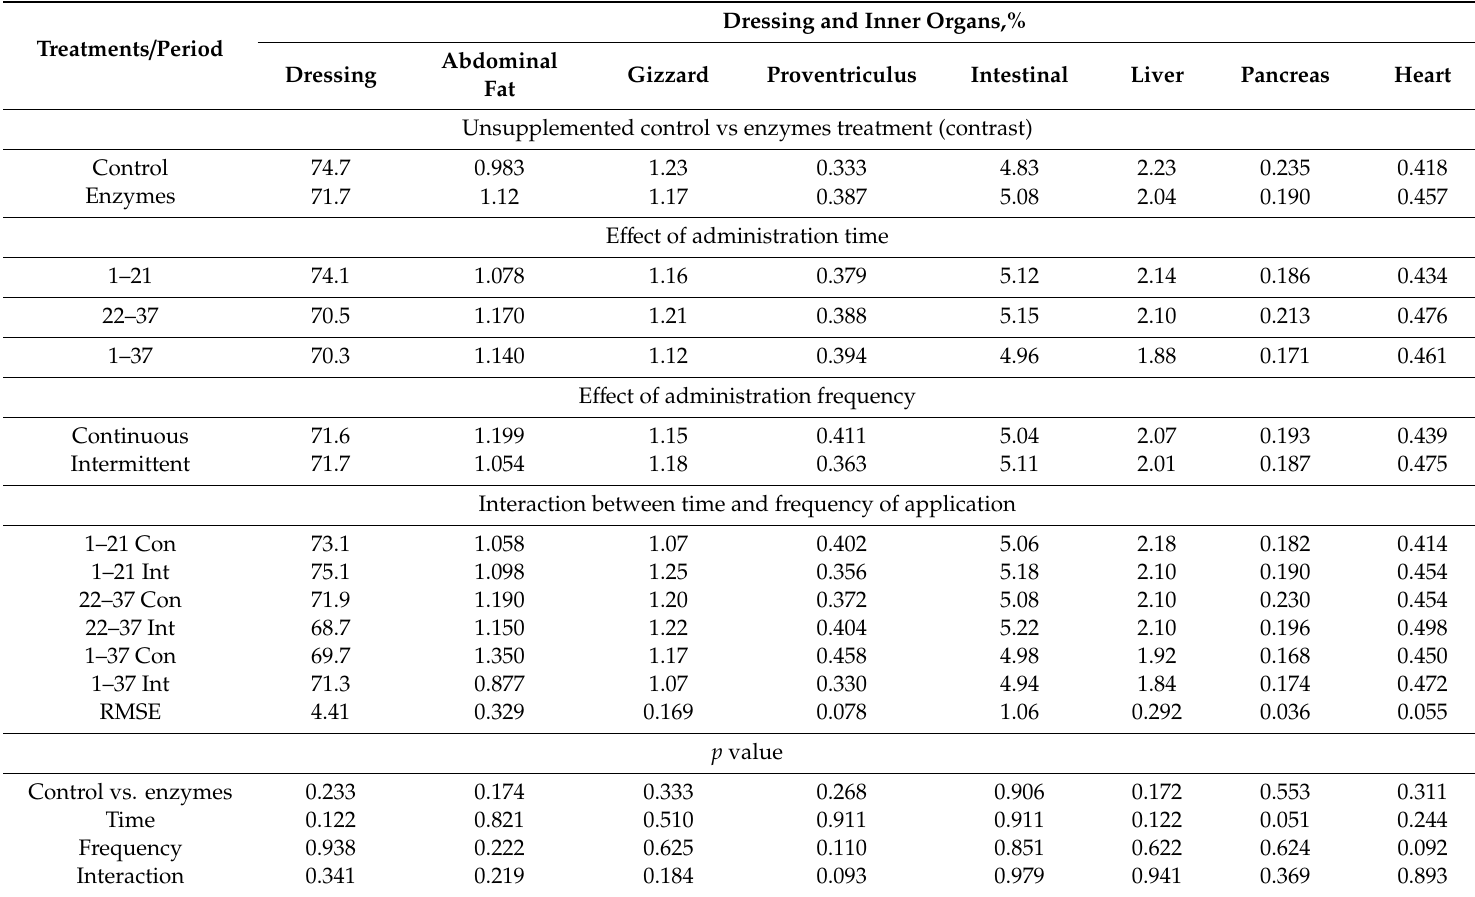
Table 4. E ff ect of multienzymes supplemented in water continuously or intermittently during the starter, grower, and the whole times on carcass characteristics and inner body organs of 37-day-old broiler